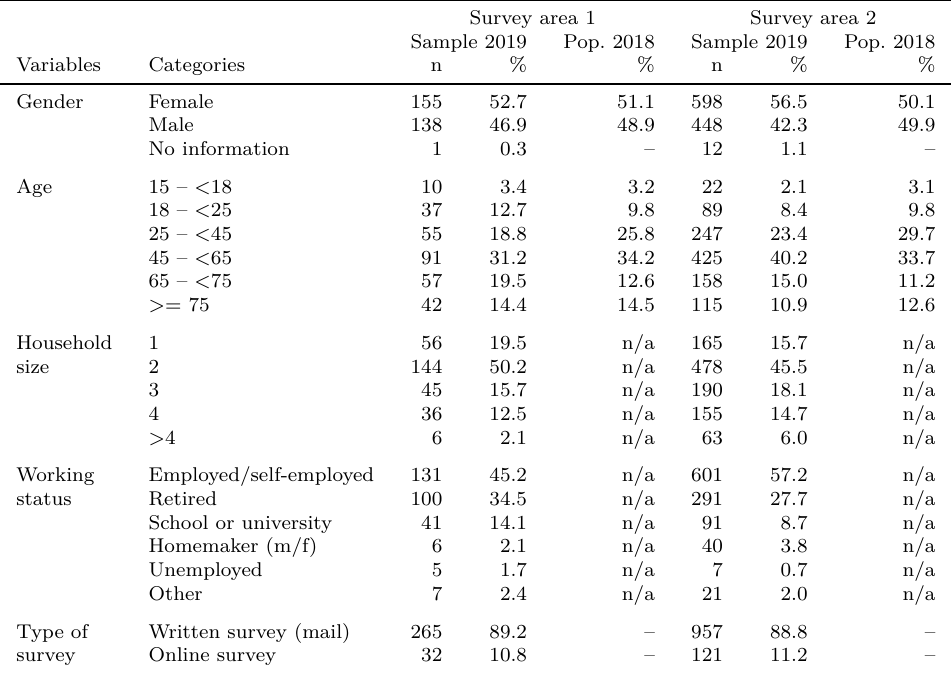
Table 1: Socio-demographic characteristics of the respondents by survey